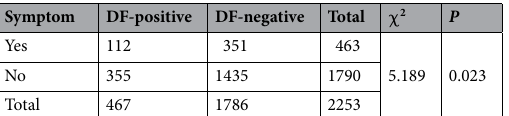
Table 4. Ocular symptoms in Demodex folliculorum (DF) positive and negative subjects [number].